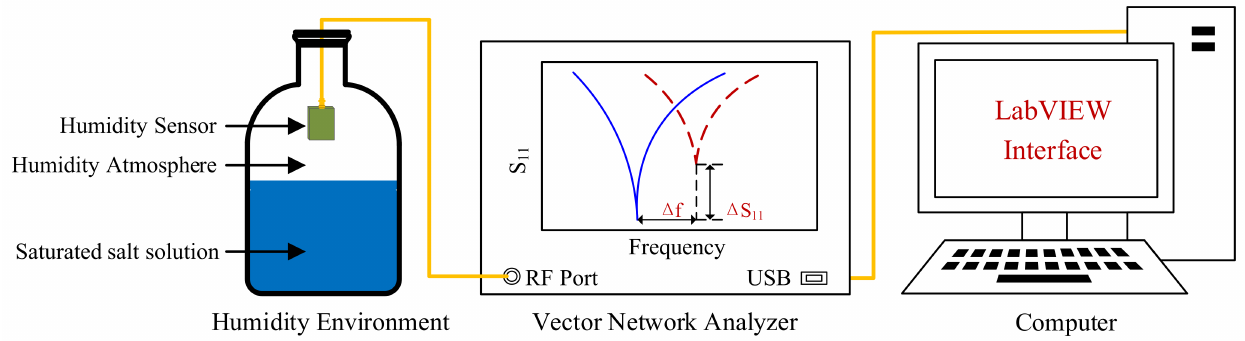
Figure 4. Measurement system for humidity sensing. Reproduced with permission from [25]. Copyright © 2021, IEEE.